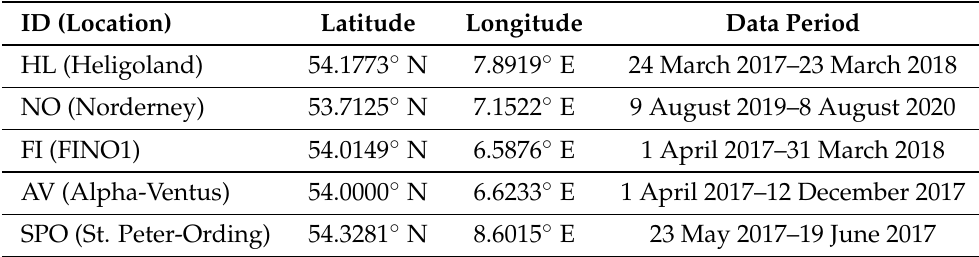
Table 1. Location coordinates (WGS 84) and data period of the wind lidar systems used in this